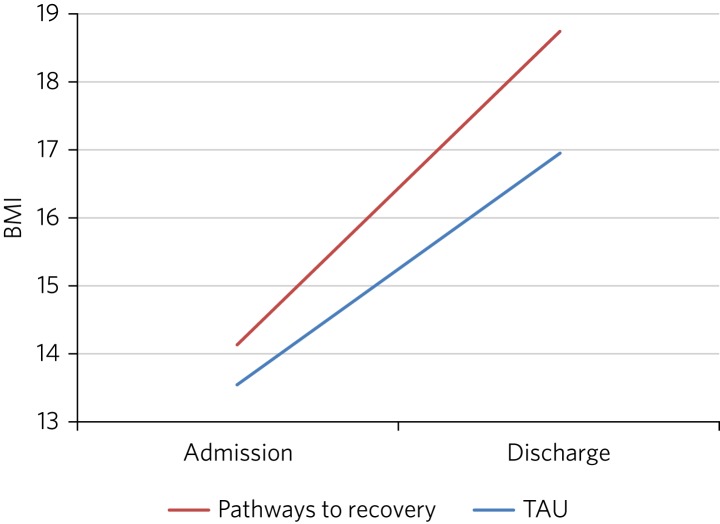
Effect of treatment on BMI.